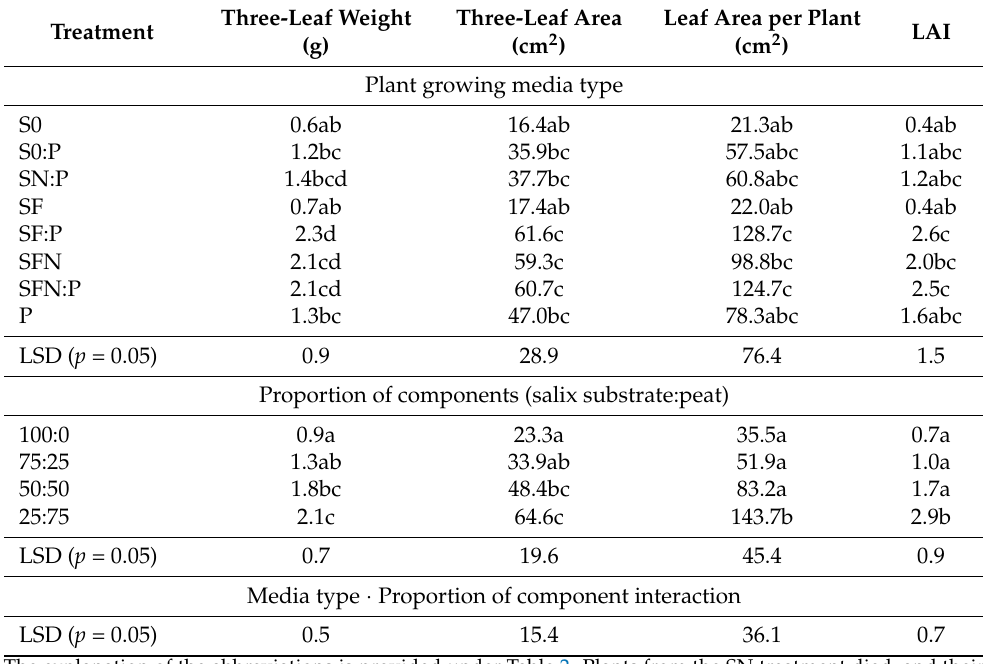
Table 7. The effect of horticulture media on leaf parameters and the LAI index.